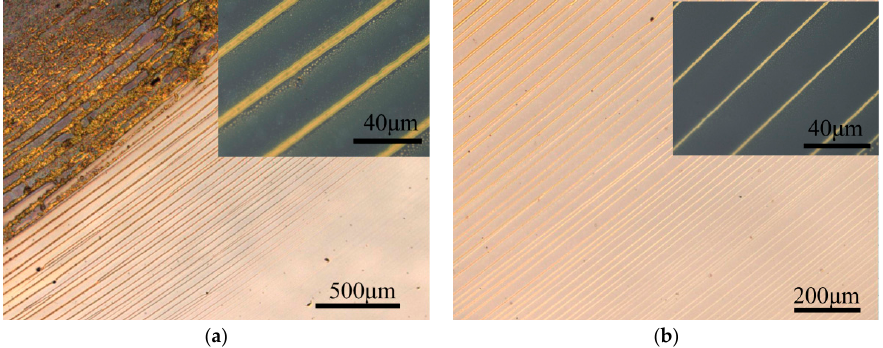
Figure 5. Optical microscope images of RR-P3HT patterns formed by evaporation under flexible geometric confinement, in the central region ( a ) and outside region ( b ).